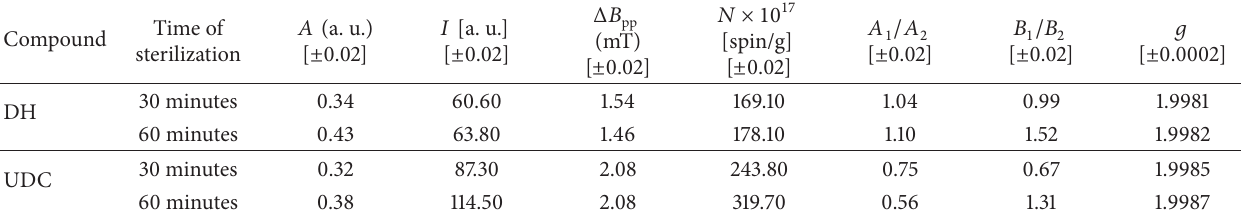
Table 1: Parameters of the EPR spectra of UV irradiated dehydrocholic acid (DH) and also ursodeoxycholic acid (UDC). Time of Compound